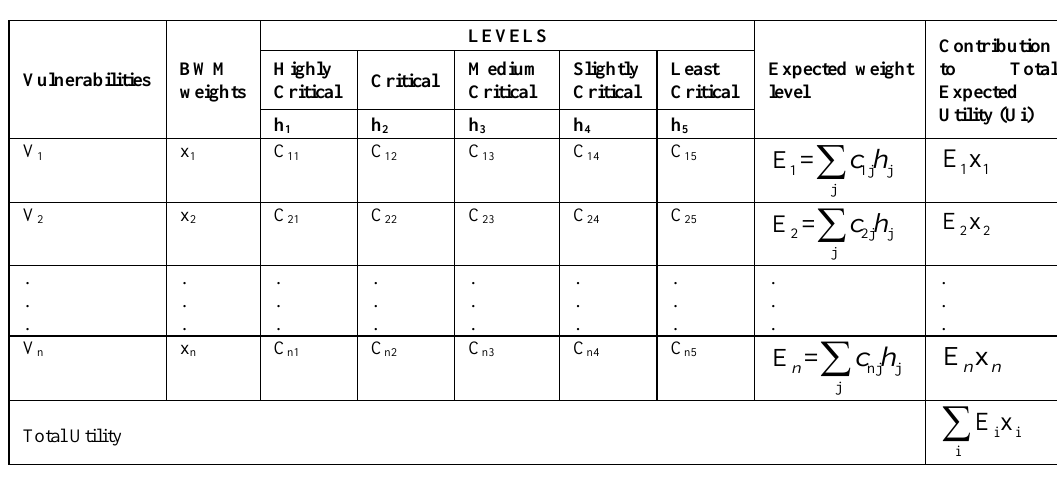
Table 3. Overall utility measure for BWM